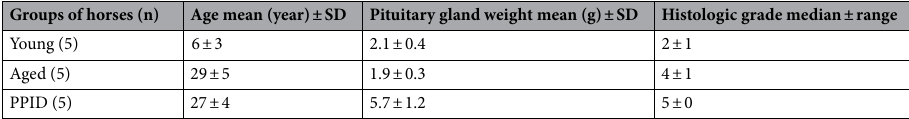
Groups of horses